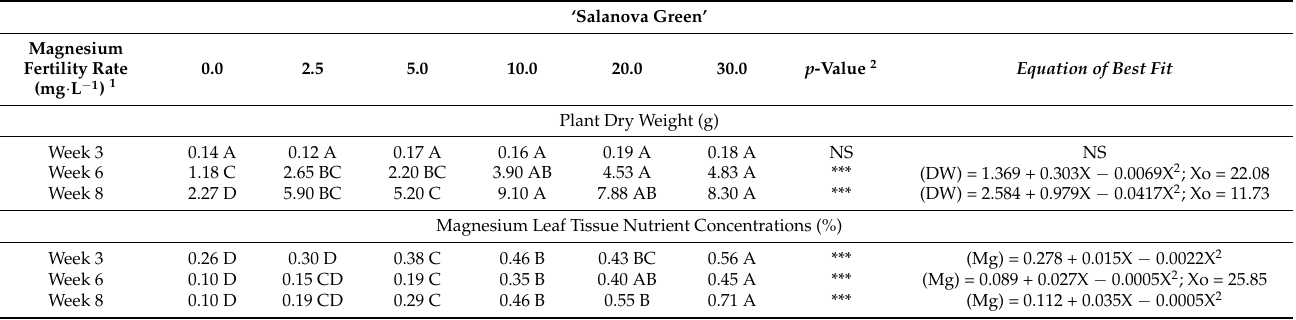
Table 7. Impact of magnesium fertility rate on plant dry weight and magnesium leaf tissue concen- tration on ‘Salanova Green’